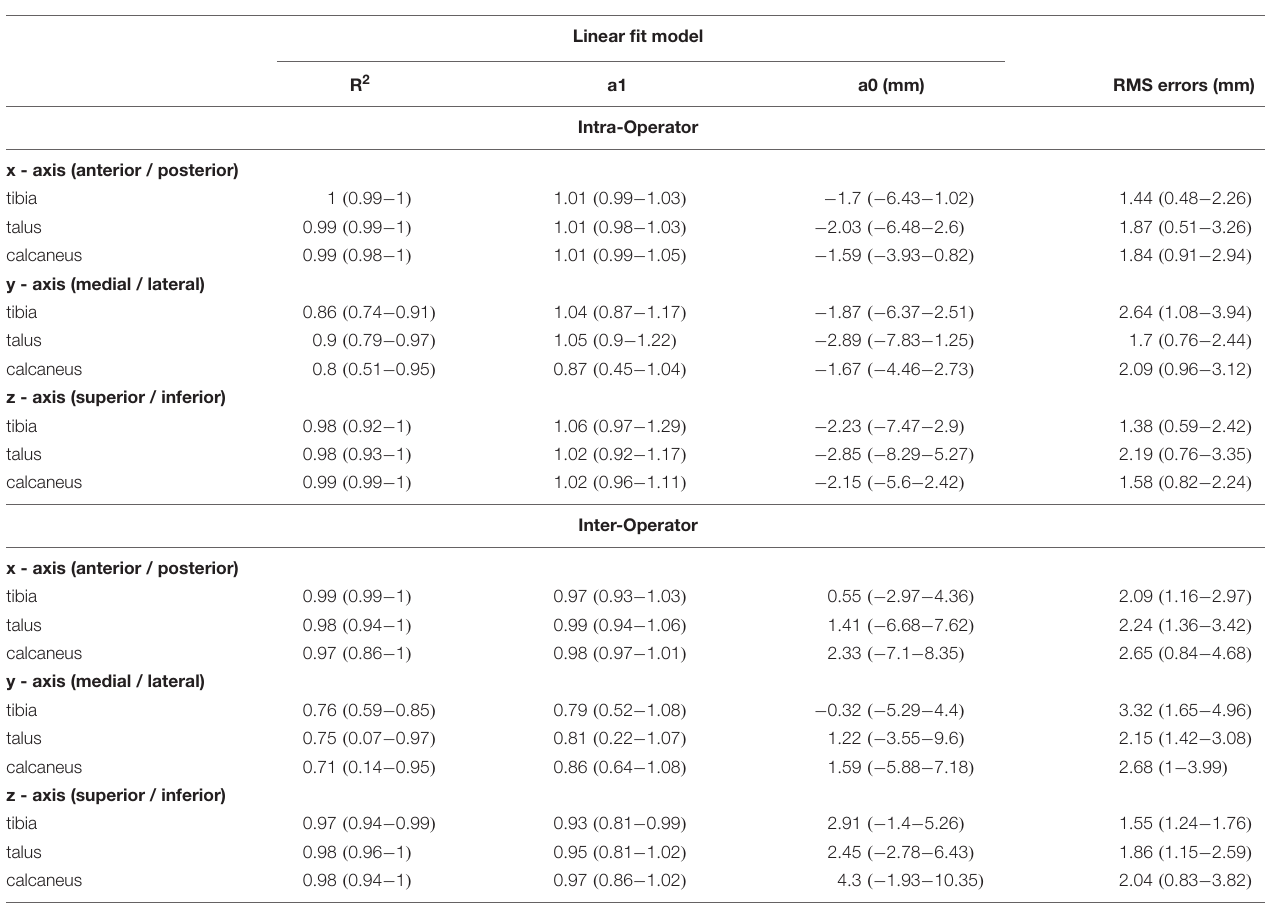
TABLE 1 | Intra- and inter- operator reliability scores for bone